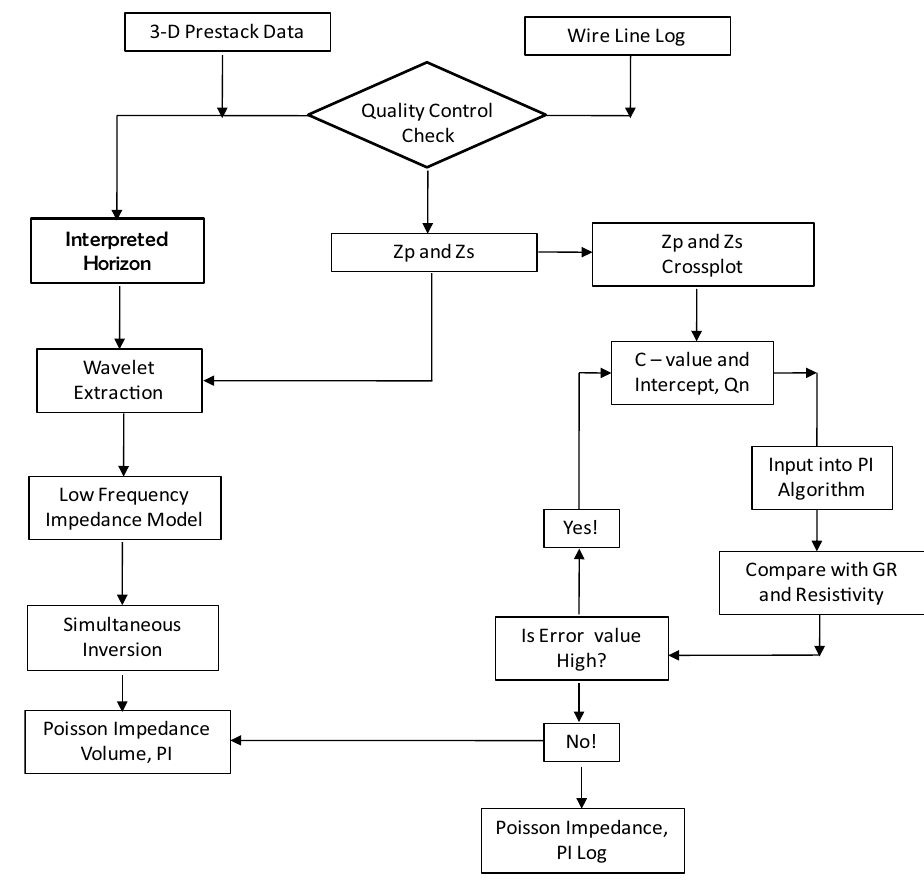
Fig. 4 Schematic workflow of model-based simultaneous inversion for Poisson impedance extraction by combined use of seismic and well log